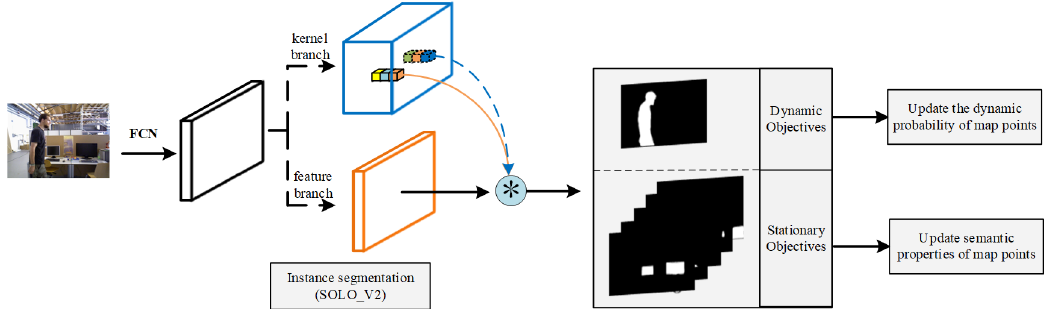
Figure 9. Processing operations in semantic threads.